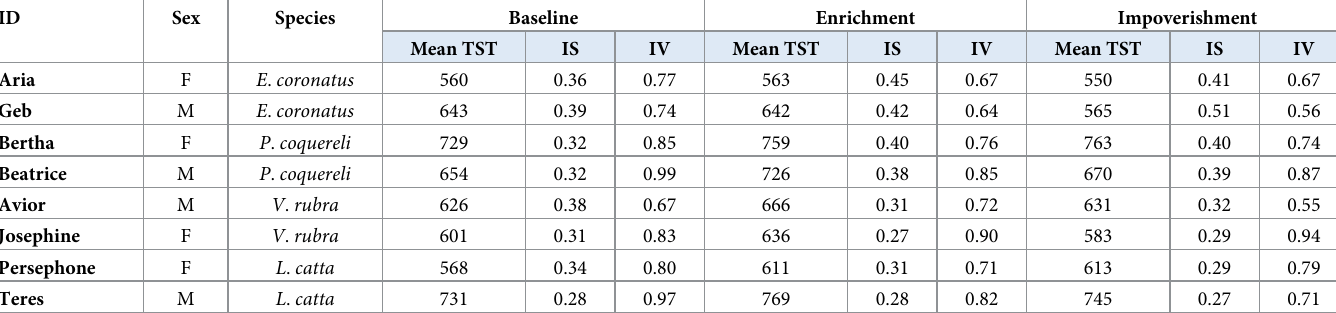
Table 1. Summarized sleep times by individual and experimental condition.